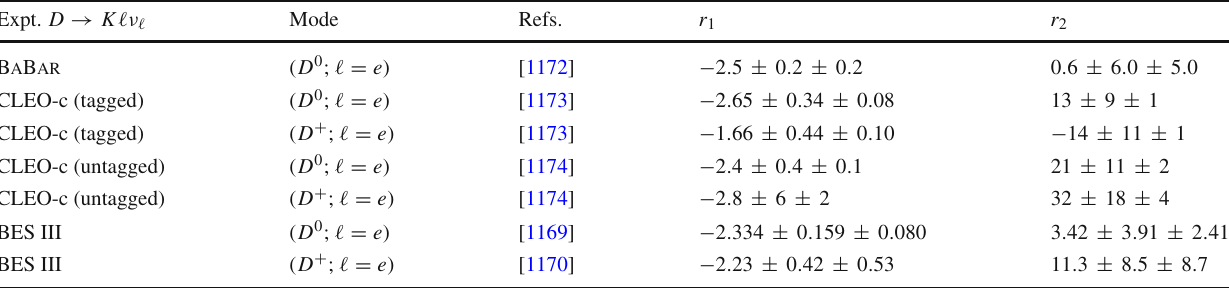
Table 273 Results for r 1 and r 2 from various experiments for the D → K (cid:12)ν (cid:12) decay channel. The correlation coefficient between these parameters is larger than 0.9 Expt. D → K (cid:12)ν (cid:12)